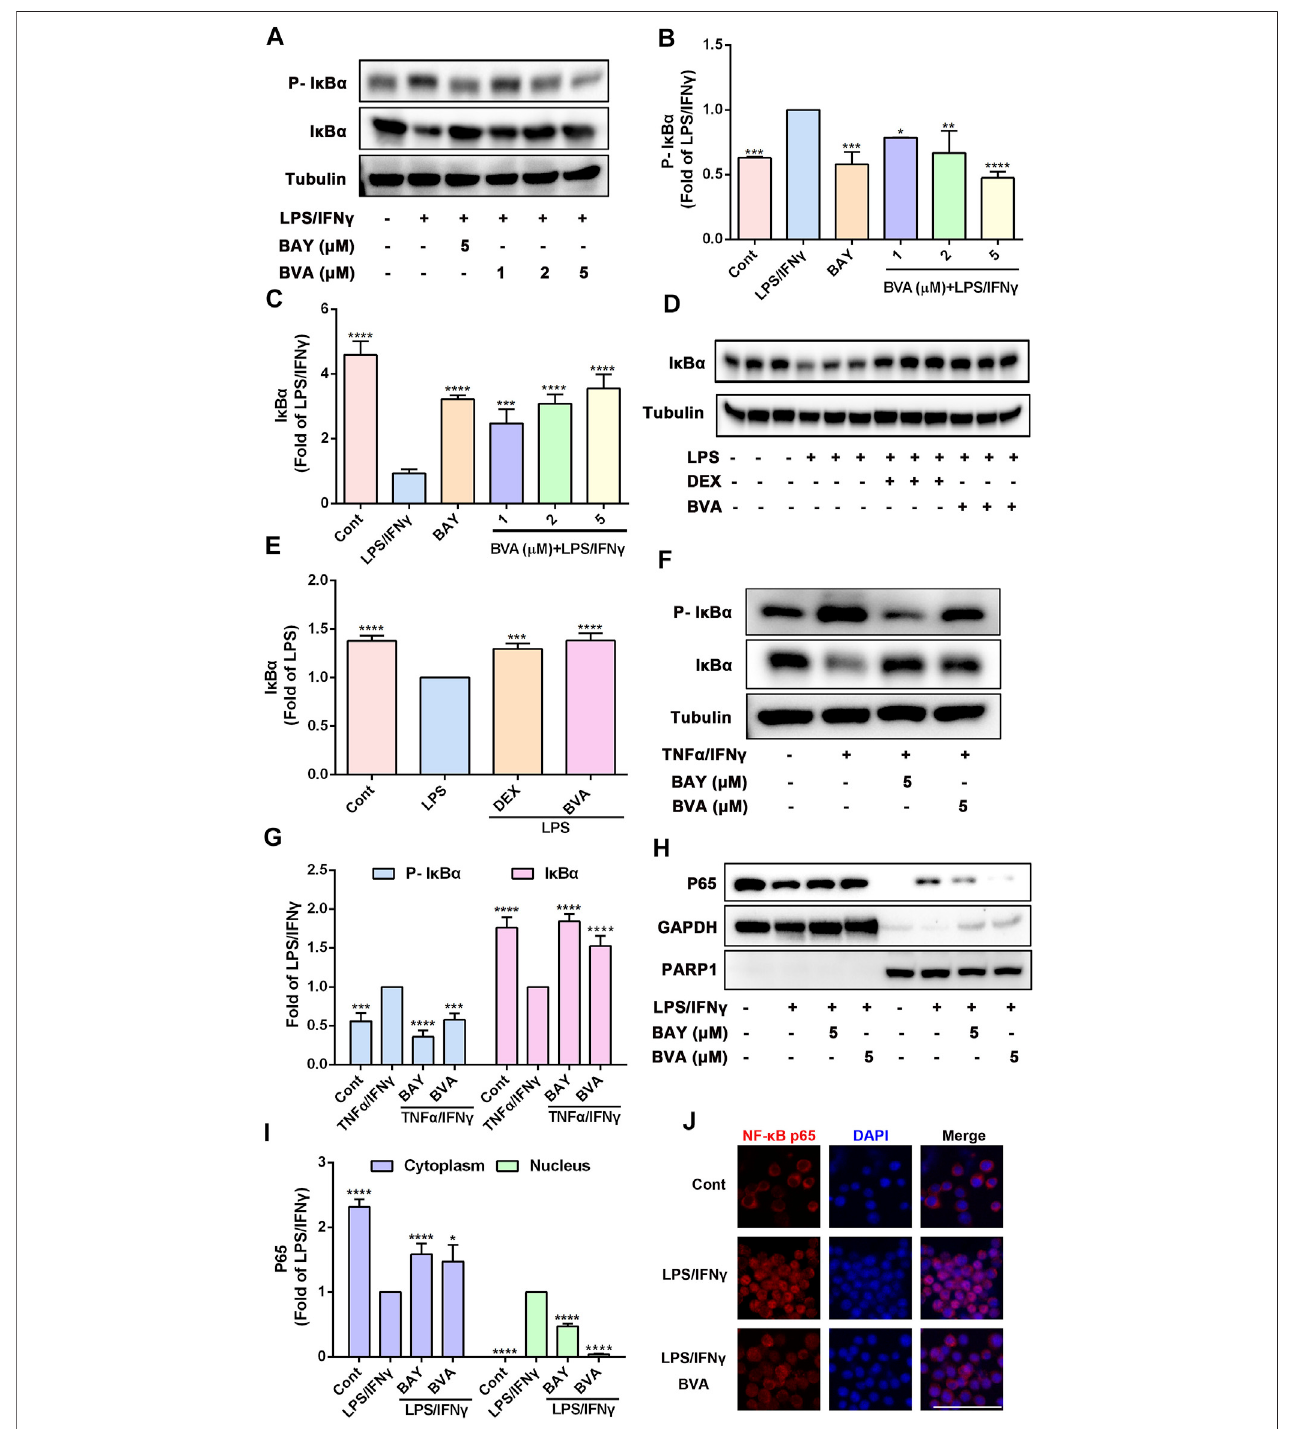
FIGURE 4 | Brevilin A suppresses the activation of NF- κ B pathway in vitro and in vivo. RAW264.7 cells treated with BVA (1, 2, and 5 μ M) or BAY (BAY11-7082, 5 μ M)for2 handthenstimulatedwithLPS/IFN γ (0.5and10 ng/ml)for5 minorTNF α /IFN γ (10and10 ng/ml)for10 min,respectively.Whole-celllysatesfromLPS/IFN γ - activated cells (A) or TNF α /IFN γ -stimulated cells (F) were used to detect the phosphorylation and degradation levels of I κ B α by western blotting, respectively. The quanti fi cation of the ratio of phosphorylated I κ B α ( B,G ) or total I κ B α ( C,G ) normalized to tubulin are shown. (D,E) Protein levels of I κ B α in lung tissues from BVA-, DEX-, or vehicle-treated mice that had been stimulated with LPS were determined by immunoblotting and normalized using Tubulin. (H) RAW264.7 cells were treated withBVAorBAYfor2 h,followedbystimulatingwithLPS/IFN γ for30 min.ThecytoplasmicandnuclearfractionswerethensubjectedtodetectthedistributionofNF- κ B p65 via immunoblotting. GAPDH and PARP1 were used as loading controls, respectively. (I) Statistical results of the ratio of p65 normalized to GAPDH or PARP1 are presented. (J) Immuno fl uorescent assessment of nuclear translocation of NF- κ B p65 (red) in RAW264.7 cells. Cells were counterstained with DAPI (blue). Scale bar = 25 μ m * p < 0.05, ** p < 0.01, *** p < 0.001, **** p < 0.0001, vs. LPS, LPS/IFN γ or TNF α /IFN γ .